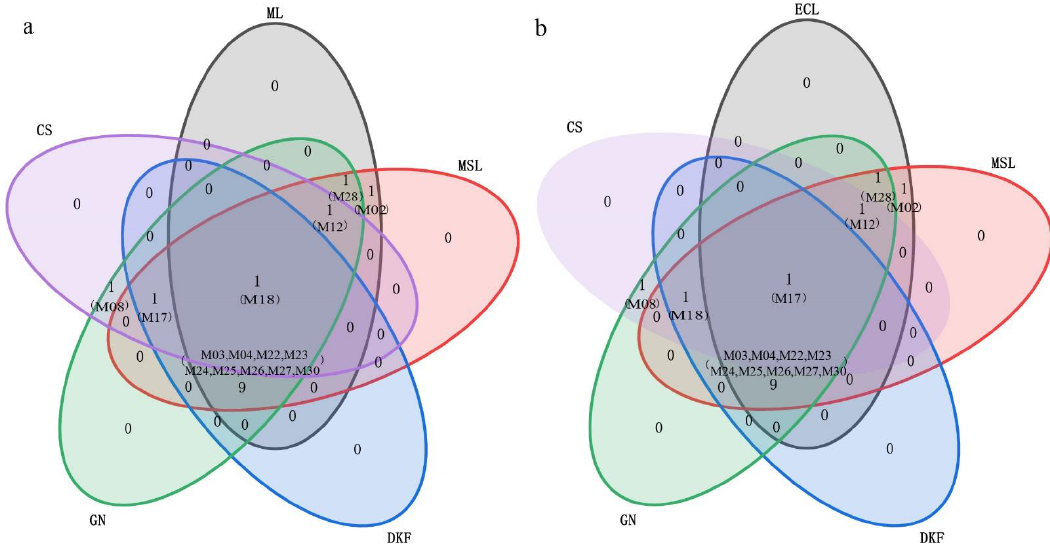
Figure 3. Venn diagrams of the suitability of SSR markers for disease resistance in hybrid popula- tions produced by different combinations. ML, ECL, MSL, DKF, GN, and CS represent varieties of Meili, Ecolly, Marselan, Dunkelfelder, Garanior, and Cabernet Sauvignon. ( a ) shows four combina- tions of disease-resistant cultivar Meili with the four susceptible cultivars Marselan, Dunkelfelder, Garanior, and Cabernet Sauvignon. ( b ) shows the four combinations of disease-resistant cultivar Ecolly with the four susceptible cultivars Marselan, Dunkelfelder, Garanior, and Cabernet Sauvi- gnon.